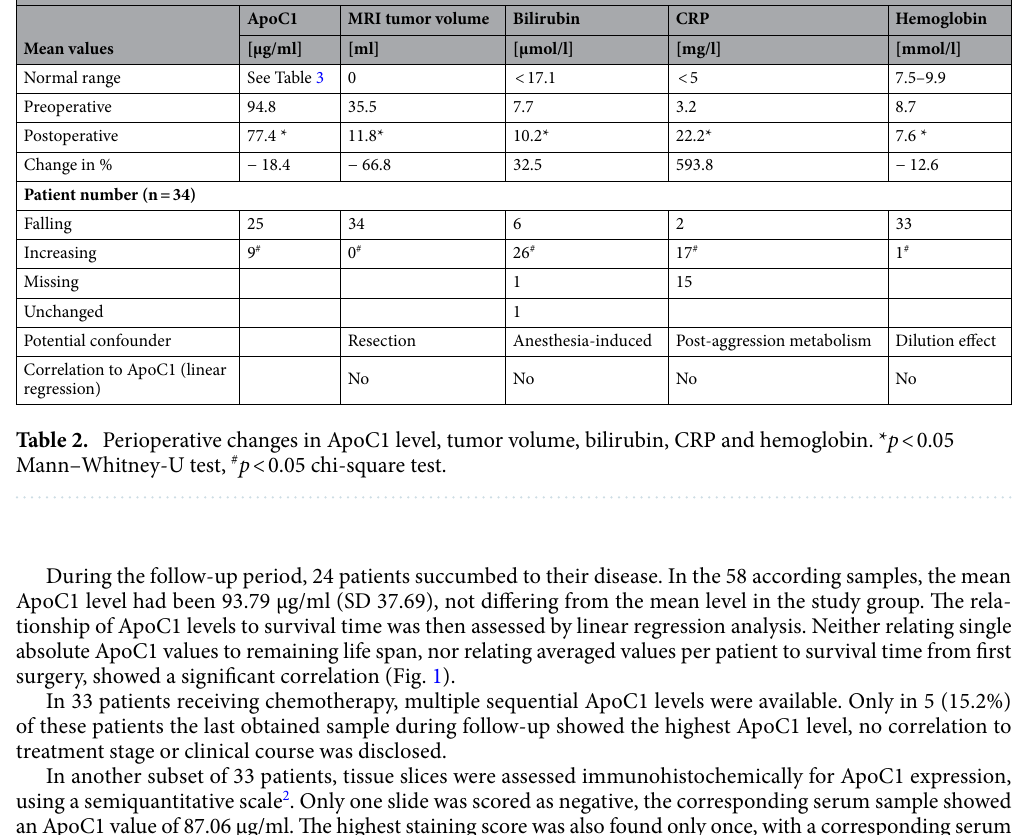
Parameters with significant differences between preoperative and postoperative values after first neurosurgical intervention ApoC1 MRI tumor volume Bilirubin CRP Hemoglobin Mean values [µg/ml] [ml] Normal range See Table 3 0 <